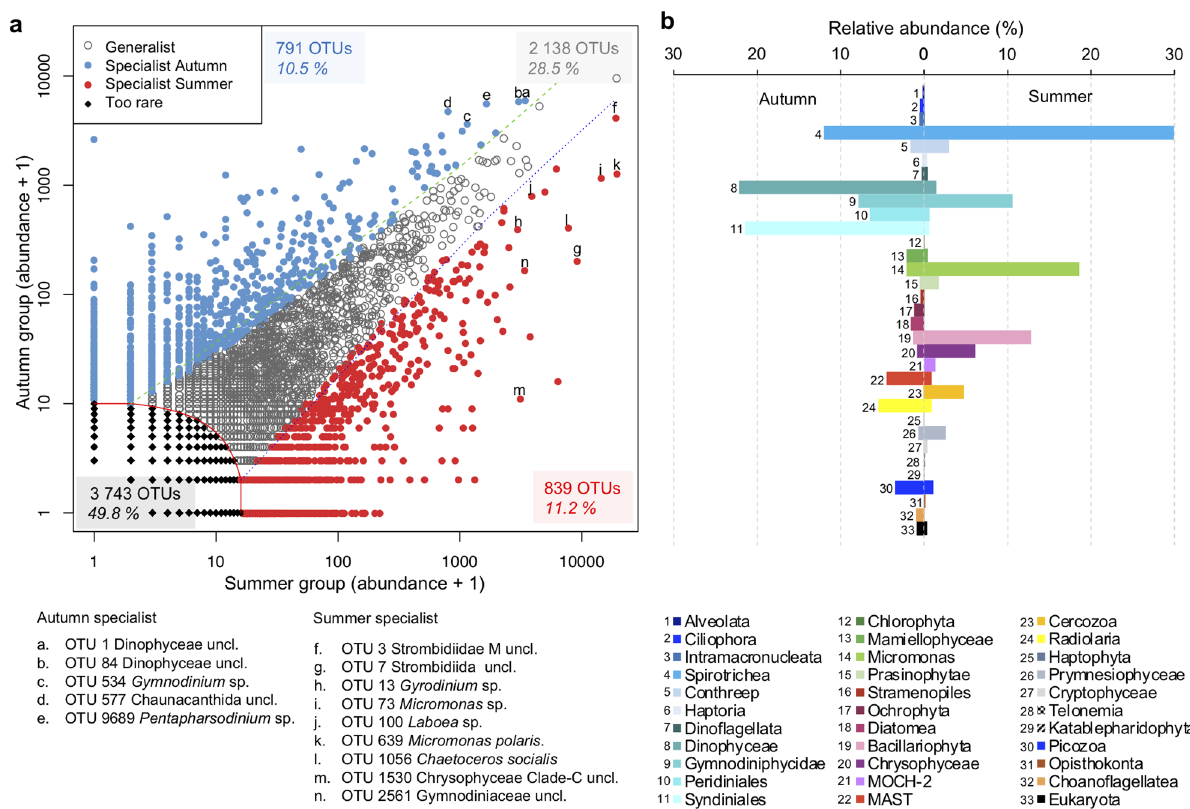
Figure 5. Specialist taxa in summer versus autumn inferred using the CLAM test (see main text). ( a ) The CLAM test plot of all OTUs in summer (July–August, n = 42) and autumn samples (October, n = 28) from both sides, both depths (surface and SCM), from both rRNA and rDNA datasets of all years (2005–2018), excluding 2006 and 2008 from September samples. Note that OTUs with < 10 reads were too rare to be classified. Percentage of total OTUs following the color code. The points marked with letters indicate the position of “top” seasonal indicator OTUs (see Fig. 6). ( b ) Relative abundance of the major groups in summer and autumn (number of reads), legend correspondence is given by both colors and